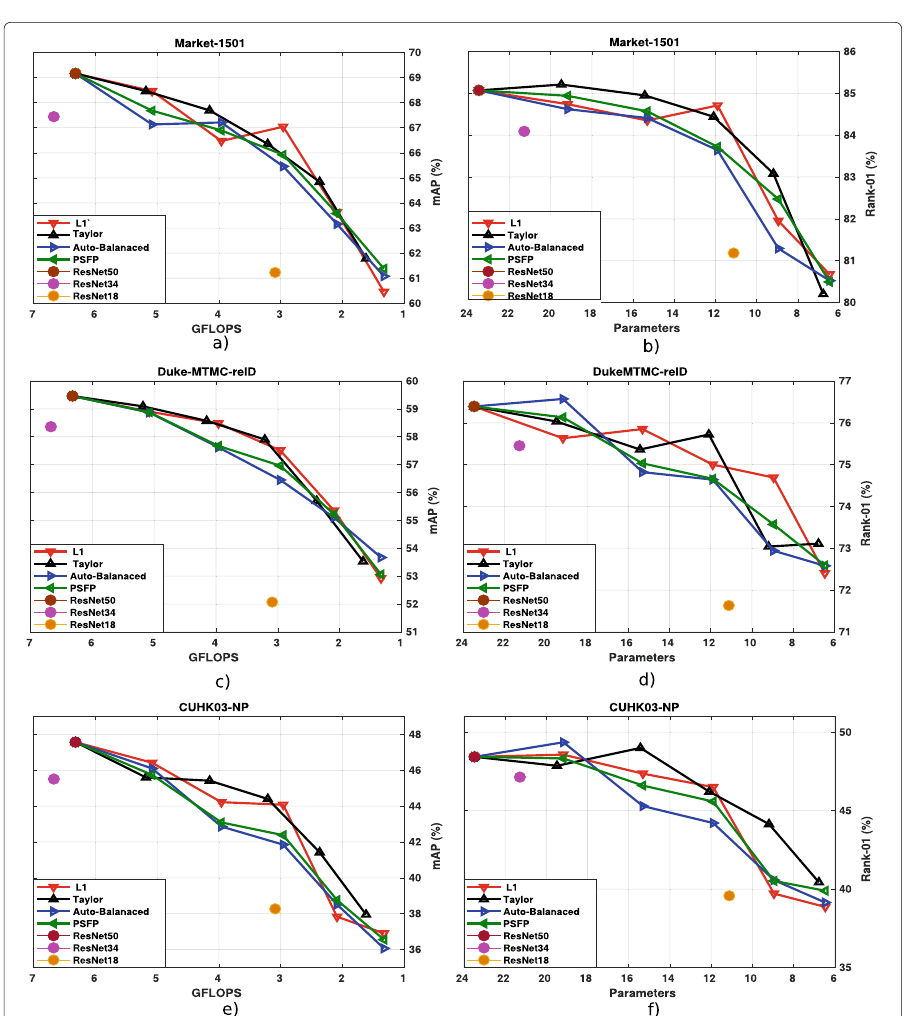
Fig. 3 Comparative ReID performance analysis of the pruning methods for all the ReID datasets: a , c , e mAP vs GFLOPS and b , d , f Parameters vs